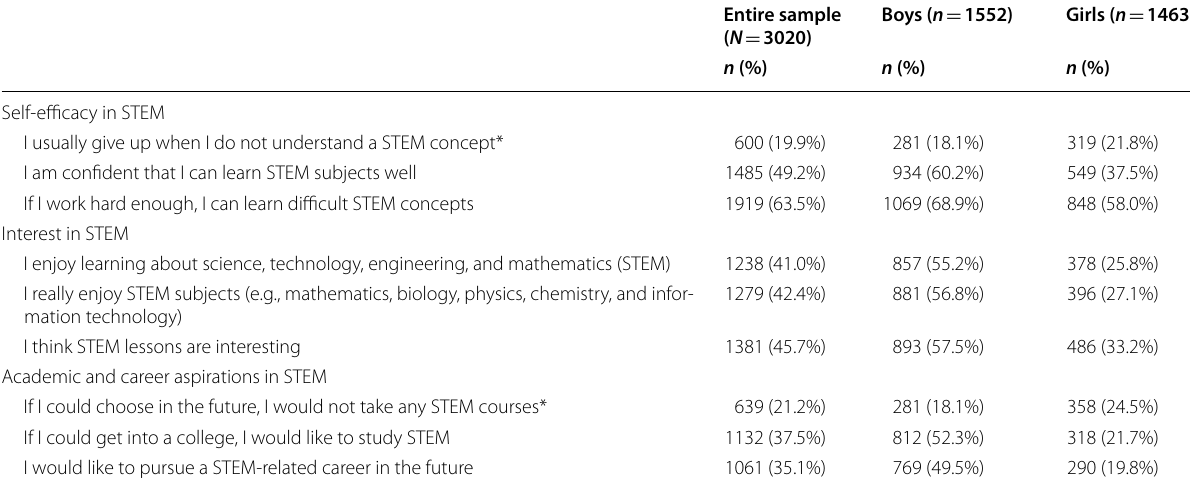
*Items are reverse